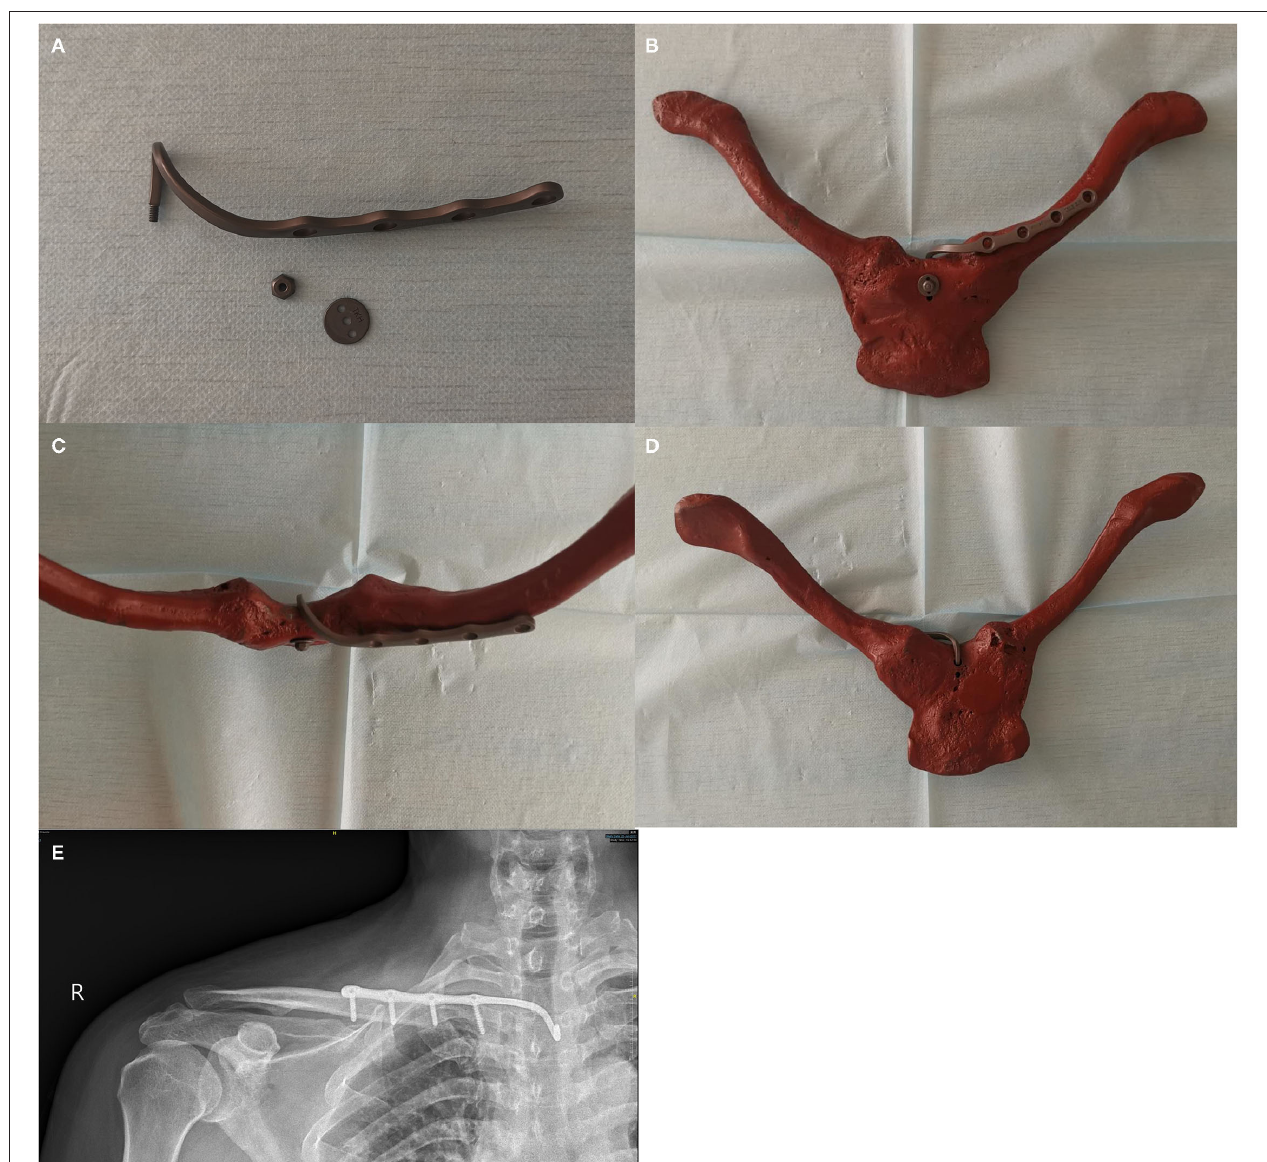
FIGURE 1 | Sternoclavicular-joint specific plate (A) and its appearance fixed in a specimen from different directions [ (B) anterior view; (C) superior view; (D) posterior view] and in postoperative X-ray (E) .